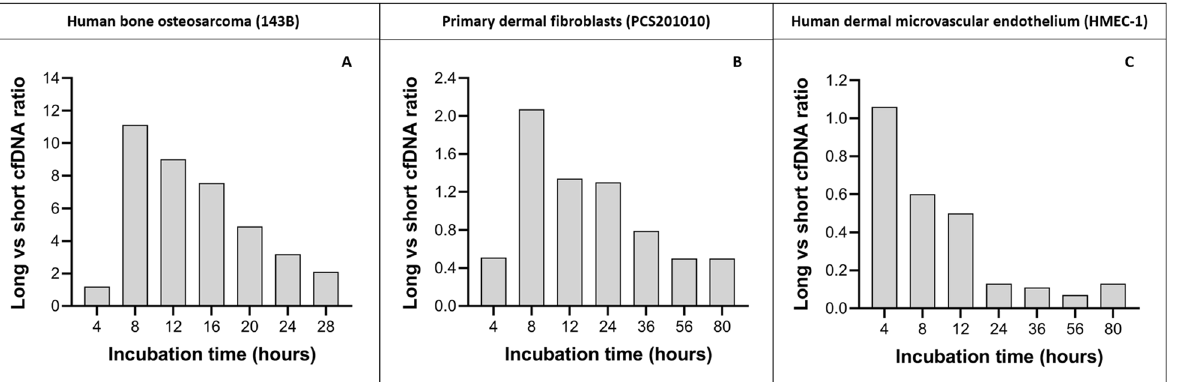
Figure 4. Ratio of long to short cfDNA fragments. Cell-free DNA (cfDNA) size profiles for each time-point were generated using an Agilent Bioanalyzer and High Sensitivity DNA kit. The size profiles were gated into two groups corresponding to the total contribution (pg/µl) of both short (50–250 bp) and long (650–10,000 bp) cfDNA populations using the size-gating function of the onboard Expert 2100 software. To illustrate the relationship between these populations we plotted the ratio of long to short cfDNA fragments over time for (A) Human bone osteosarcoma (143B), (B) primary dermal fibroblasts (PCS201010), and (C) human dermal microvascular endothelial (HMEC-1) cell